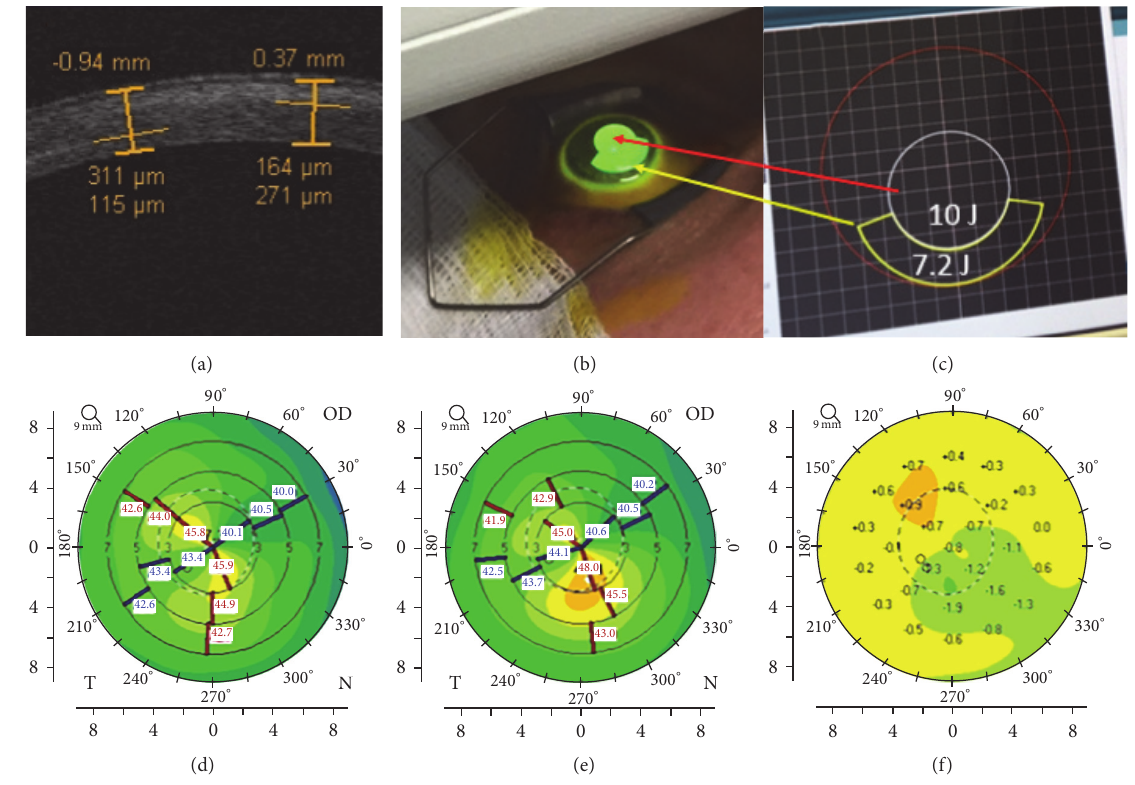
Figure 4: Corneal OCT following high-irradiance topography-guided CXL. At 3rd postoperative month (a), multiple demarcation lines due to the different energy doses delivered according to the topography-guided CXL protocol were evident. (b) illustrates the topography-guided treatment in progress. (c) shows the topo-guided treatment planning with programmed double energy dose: 7.2 J/cm 2 in the flattest area under 48 D (yellow arrow) with arc-step pattern, and 10J/cm 2 in the steepest central area over 48 D (red arrow) with circular pattern. (d) shows the 12th month postoperative flattening compared with preoperative tomography (e), followed by compensatory steepening of the flattest superior cornea documented in differential corneal tomography